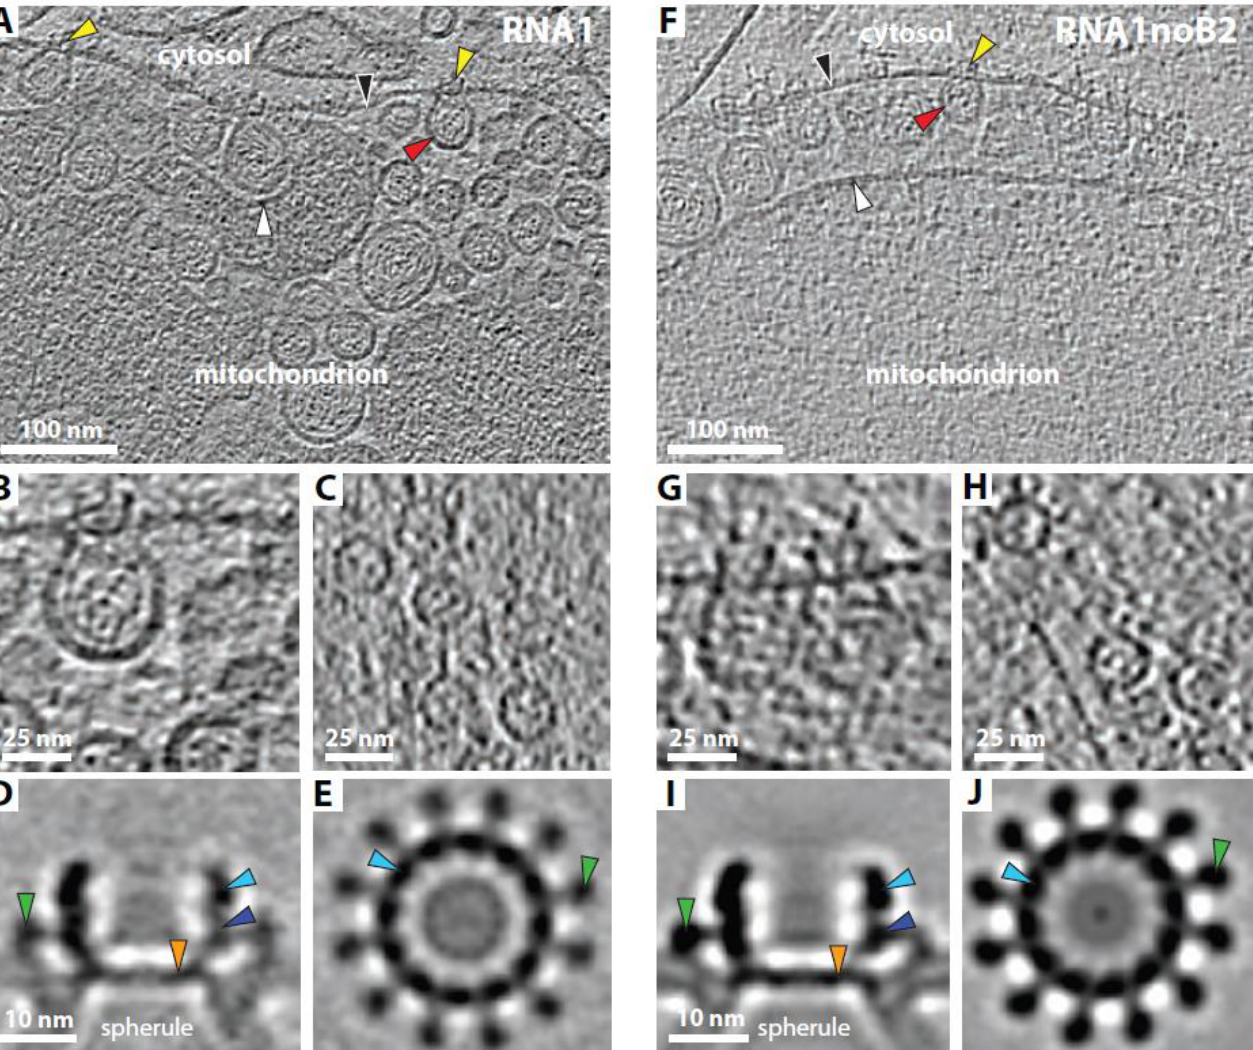
Figure 5. Cryo-ET of nodavirus RNA replication complexes in mammalian cells. ( A , F ) Indistinguishable spherules are induced on the outer mitochondrial membrane in mammalian BSRT7/5 cells transfected with either wildtype nodavirus RNA1 ( A ) or with RNA1-noB2 ( F ). Arrowheads: black = outer mitochondrial membrane; white = inner mitochondrial membrane; red = spherules, filled with dsRNA; yellow = crown-like structures at the spherule open necked connections to the cytoplasm. ( B , G ) Close-up side views of spherules with crowns visible in the plane of sectioning. ( C , H ) Close-up top views of crowns. ( D , I ) Cross sections of EM density maps of subtomogram-averaged side views of crowns. Arrowheads: light blue = apical lobe; dark blue = basal lobe; green = leg; orange = floor. ( E , J ) Cross sections of EM density maps of subtomogram-averaged top views of crowns with blue arrowheads pointing to the central crown turret and green arrowheads to the extended legs. Tomogram movies corresponding to panels A and F and Fourier Shell Correlation (FSC) curves corresponding to panels D, E, I, and J are provided in Supplementary Movies S1 and S2 and Supplementary Figure S1.